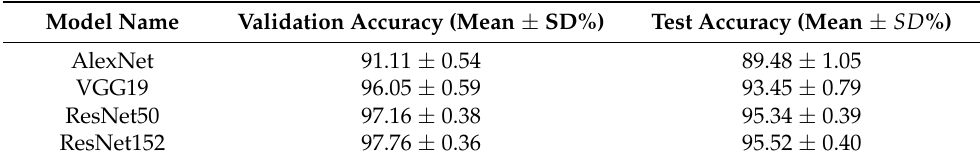
Table 3. Classification accuracies of various models on the test set.